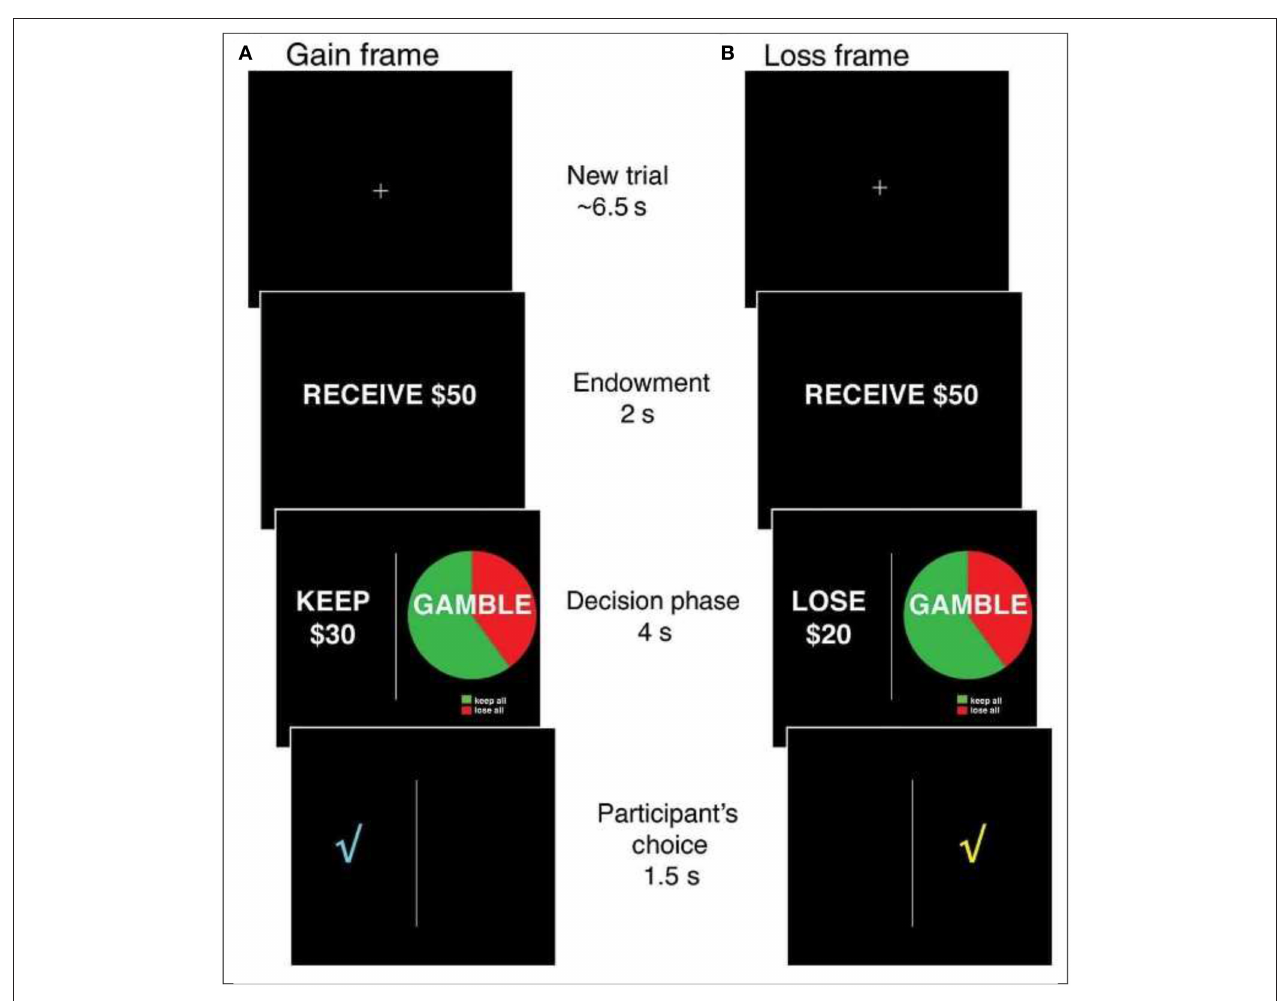
FIGURE 1 | The Risky Choice Framing task. On each trial, an initial fixation cross is presented for ∼ 6.5s, followed by the presentation of an endowment for 2s ($50 or $100). A decision screen is then presented for 4s in which a safe option is always presented on the left and a risky option is always presented on the right. The safe and risky options are always equal in terms of expected value and range between 20 and 80% of the initial endowment. After participants indicate their choice, a check mark indicating the selected option is presented for 1.5s before proceeding to the next trial. Gain (A) and loss (B) trials are pseudorandomly varied within